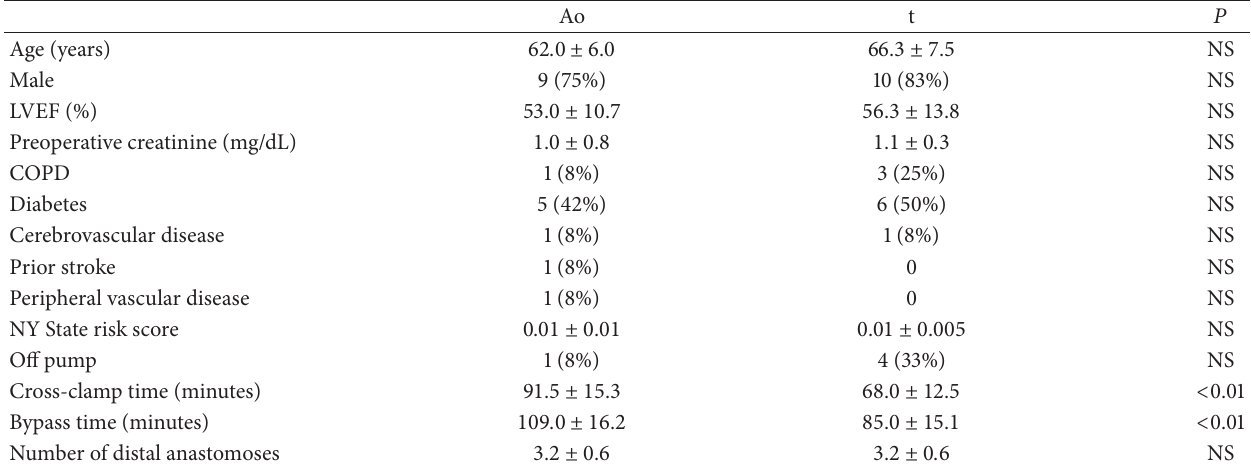
Table 2: Preoperative and intraoperative patient